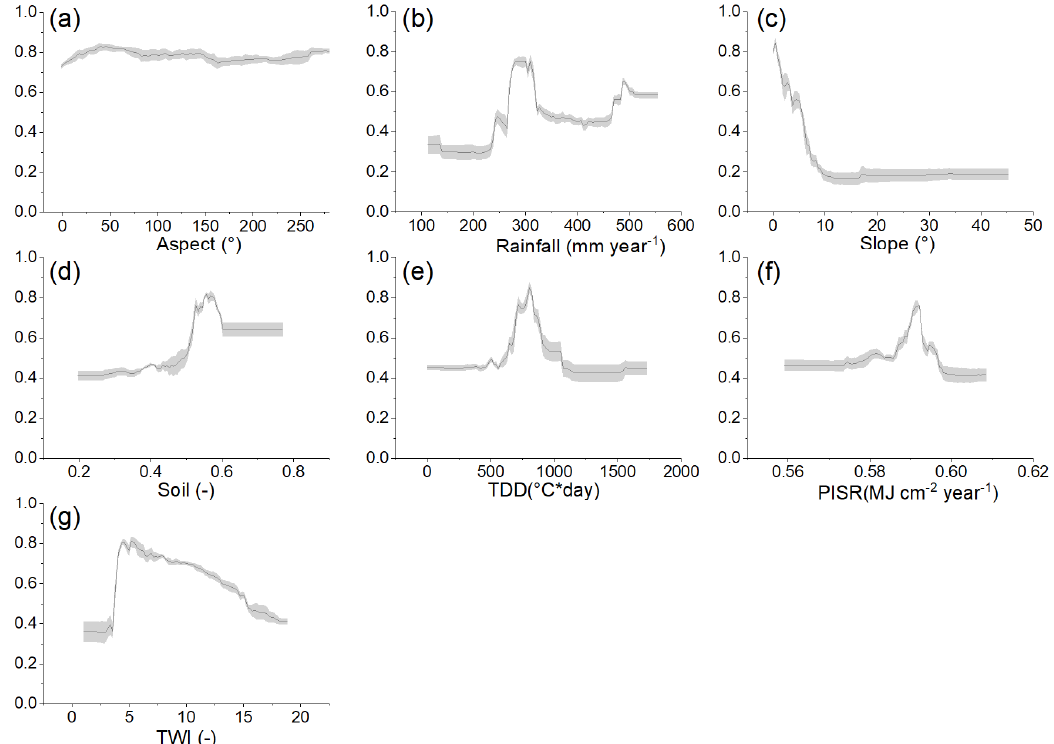
Figure 8. Univariate probability response curves for the seven environmental variables: ( a ) aspect; ( b ) rainfall; ( c ) slope; ( d ) soil; ( e ) TDD; ( f ) PISR; and ( g ) TWI. The RF model (grey line) was fit to the variable with a standard deviation (grey bands).